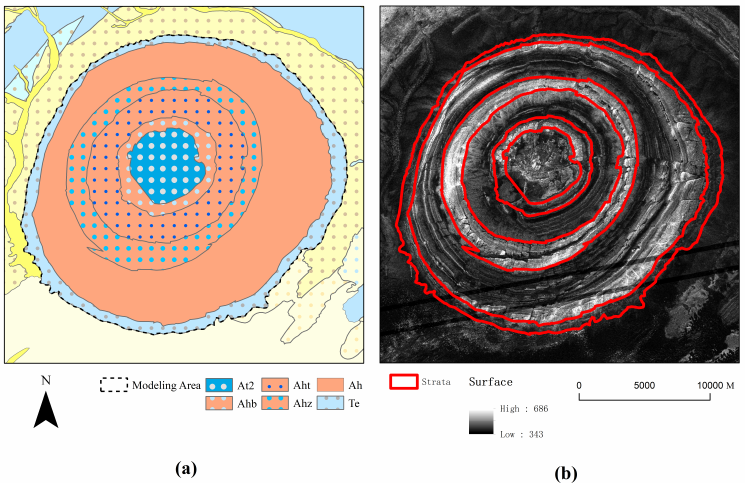
Figure 15. Richat structure experimental data: ( a ) Geological map of Richat structural; ( b ) DEM of Richat